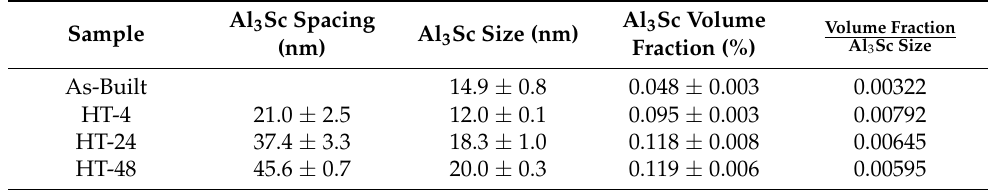
Table 3. Summary of Al 3 Sc precipitation size and volume fraction of the as-built and heat-treated samples Scalmalloy samples.